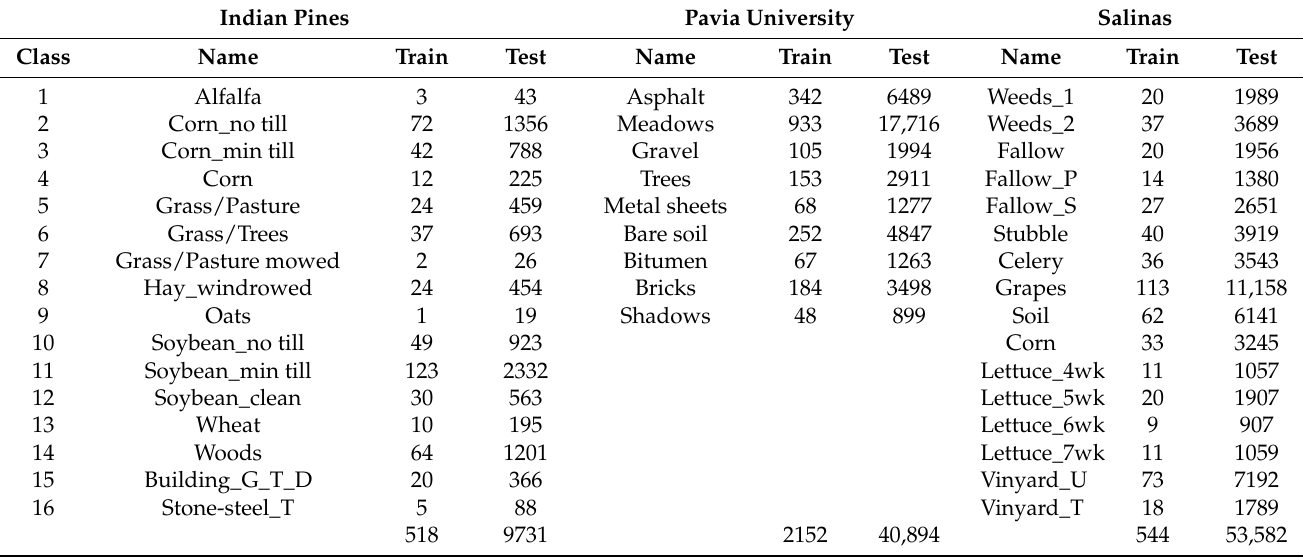
Table 1. Number of training samples and test samples for each class on three images. Indian